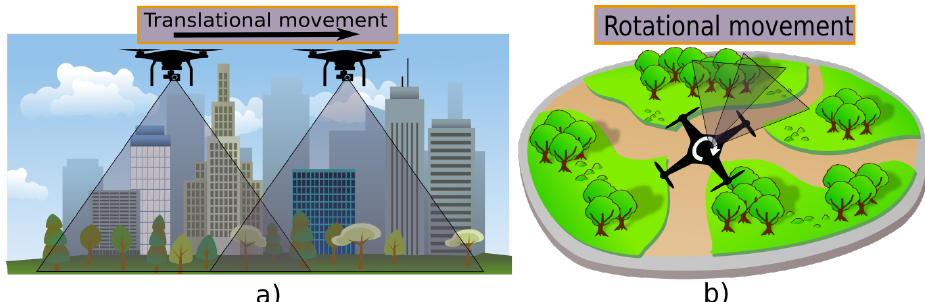
Figure 2. Image acquisition: ( a ) multiple-camera translational and rotational acquisition; ( b ) single- camera rotational